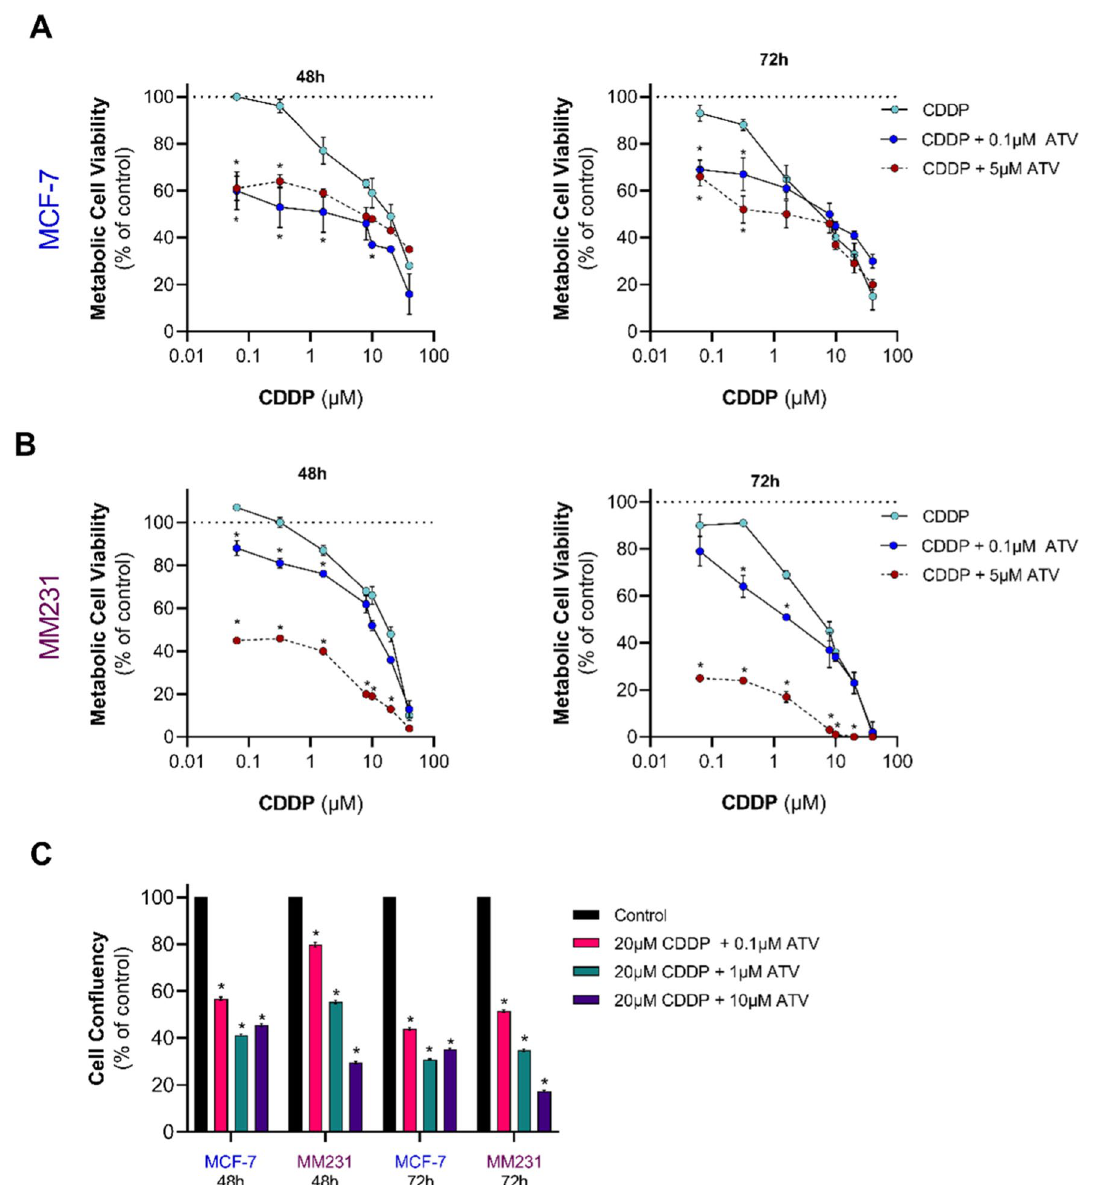
Fig. 3 Cytotoxic effects of combined treatment with CDDP and ATV on MCF-7 and MDA-MB-231 cells. A MCF-7 and B MDA-MB-231 (MM231) cell viability in DMEM and 10% FBS media containing 0.64 to 40 µM of CDDP alone or in combination with ATV (0.1 µM or lower IC previously determined – 5µM) at 48 and 72 h. The data was expressed as a percentage of treated cells viability compared to untreated 50 cells (Control). Control cell viability represented by horizontal dashed line indicating 100% cell viability. C MCF-7 and MDA-MB-231 cell con- fluency in response to solvent vehicle (Control) or co-administration of CDDP and ATV determined by IncuCyte at 48 and 72 h. Data are pre- sented as fold change to time-matched vehicle control. Data are mean ± SEM of three independent experiments performed in quadruplicate ( A – B ) or with six technical replicates ( C ). *p < 0.05 vs. Control (vehicle-treated cells) within each experiment by two-way ANOVA followed by Bonferroni post hoc test ( A & B ) or one-way ANOVA followed by Dunnett’s post hoc test ( C